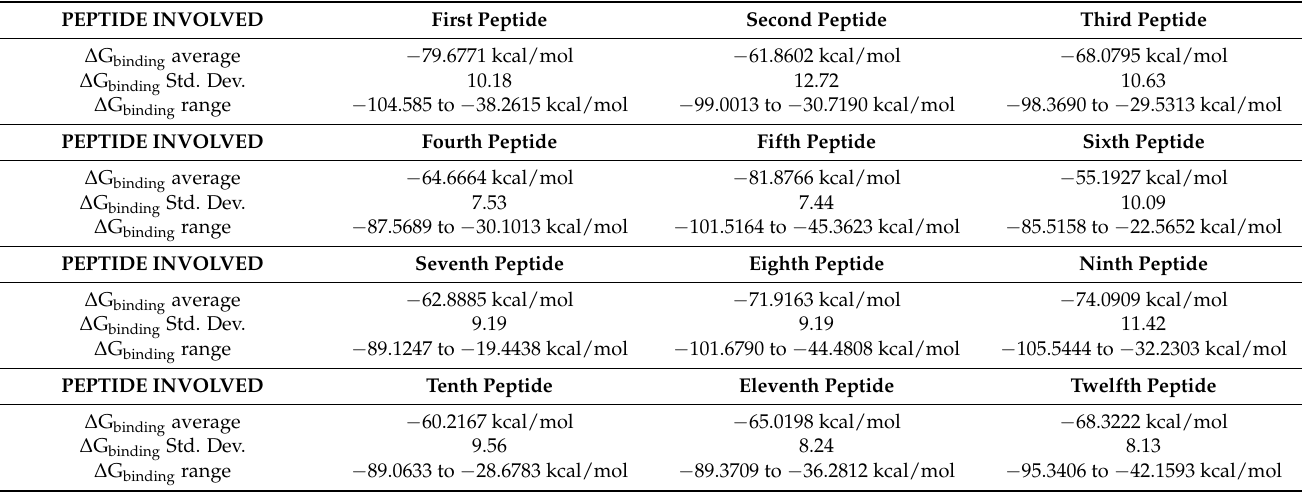
Table 5. MM-GBSA calculation results of MD simulations performed on the combinatorial peptides in complex with PBX1 protein and